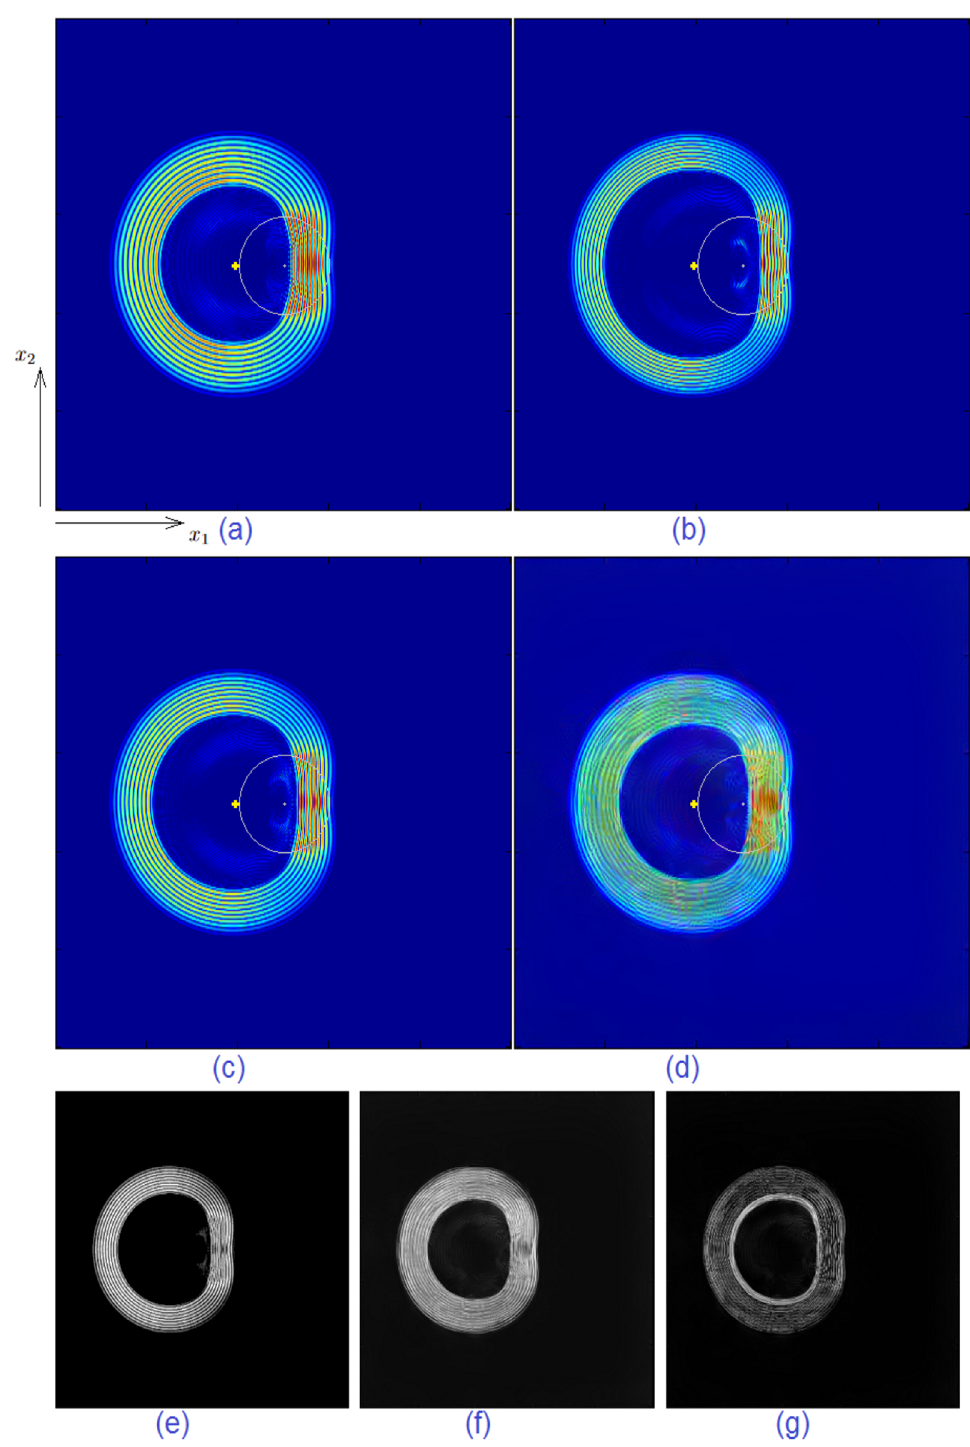
Fig. 10. Snapshot time t =480 m s, for the radiation pattern of a point force located at 5.5cm from the center of a Luneburg lens with a radius of 5cm based in the center of a fi eld of 50 cm by 50cm, with a frequency of 25 kHz (a), 35 kHz (b) and 30kHz (c); (d) show the style transfer result between (a) and (b), (e) is (c) transformed in a grayscale image, (f) is (d) transformed in a grayscale image and (g) is the absolute value of the difference between (e) and